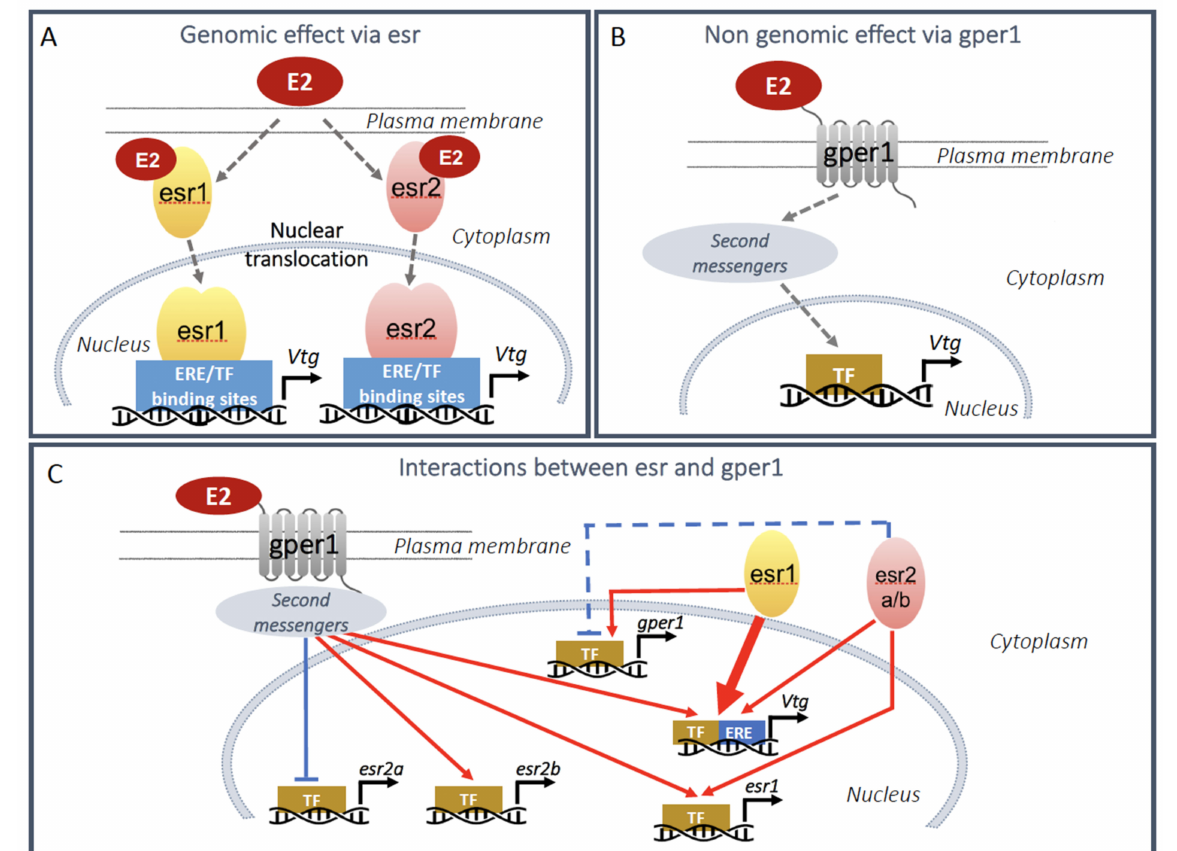
Figure 3. Signaling pathways of estrogens on vitellogenesis synthesis and interaction between esr and gper in oviparous vertebrates. ( A ) Genomic effect of E2 via esr1 and esr2 . When bound to the ERE in the regulatory region of the vitellogenin genes, E2-activated esr1 or esr2 dimers (depicted separately) stimulate the transcription of the vitellogenin genes. The ERE bound esr dimers may cooperate with other transcription factors (TF) bound to nearby TF binding sites (see text). ( B ) Non-genomic effect of E2 via gper1 . E2-activated gper1 stimulates a cascade of second messengers resulting in vitellogenin gene stimulation by transcription factors (TF). ( C ) Functional interactions between esr and gper1 . Esrs and gper1 cooperate in the regulation of the esr, gper , and vitellogenin genes. E2: 17 β -estradiol; Vtg: vitellogenin; esr: estrogen receptor; TF: transcription factor (Sp1, CTF-1, HNF3, C/EBP and others); ERE: estrogen responsive element; gper1 : g-protein coupled estrogen receptor